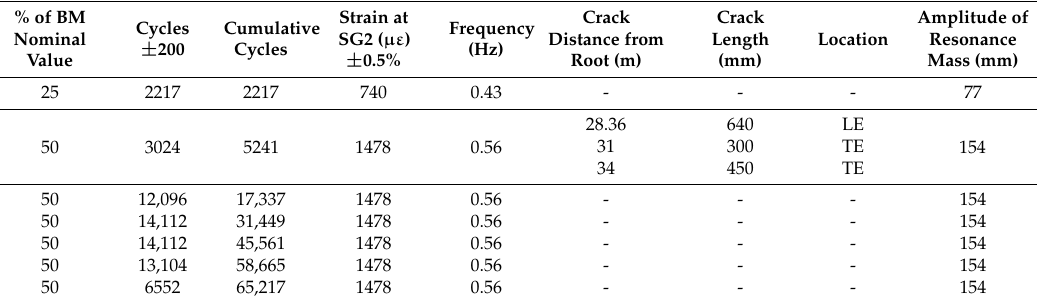
Table 3. Fatigue test results for the as received